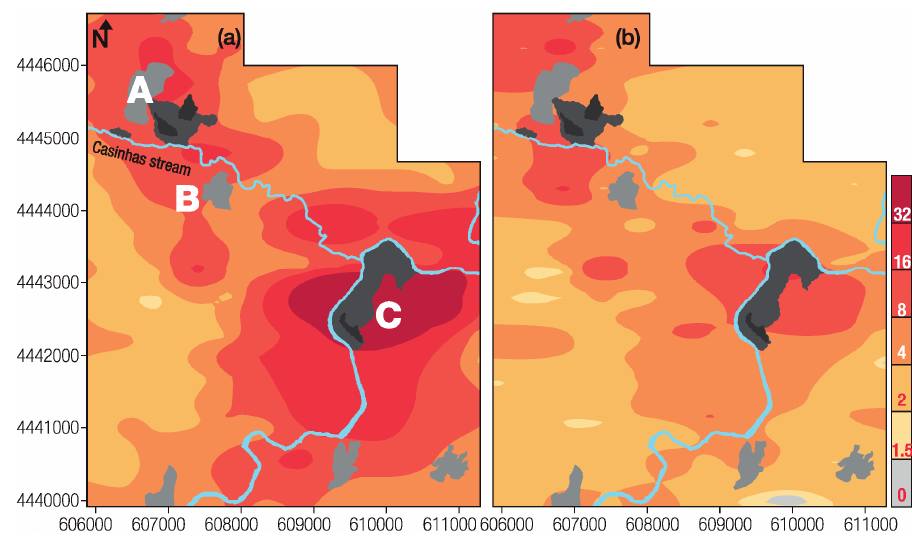
Figure 5. Spatial distribution of the modified degree of Contamination ( mC d ) for topsoil ( a